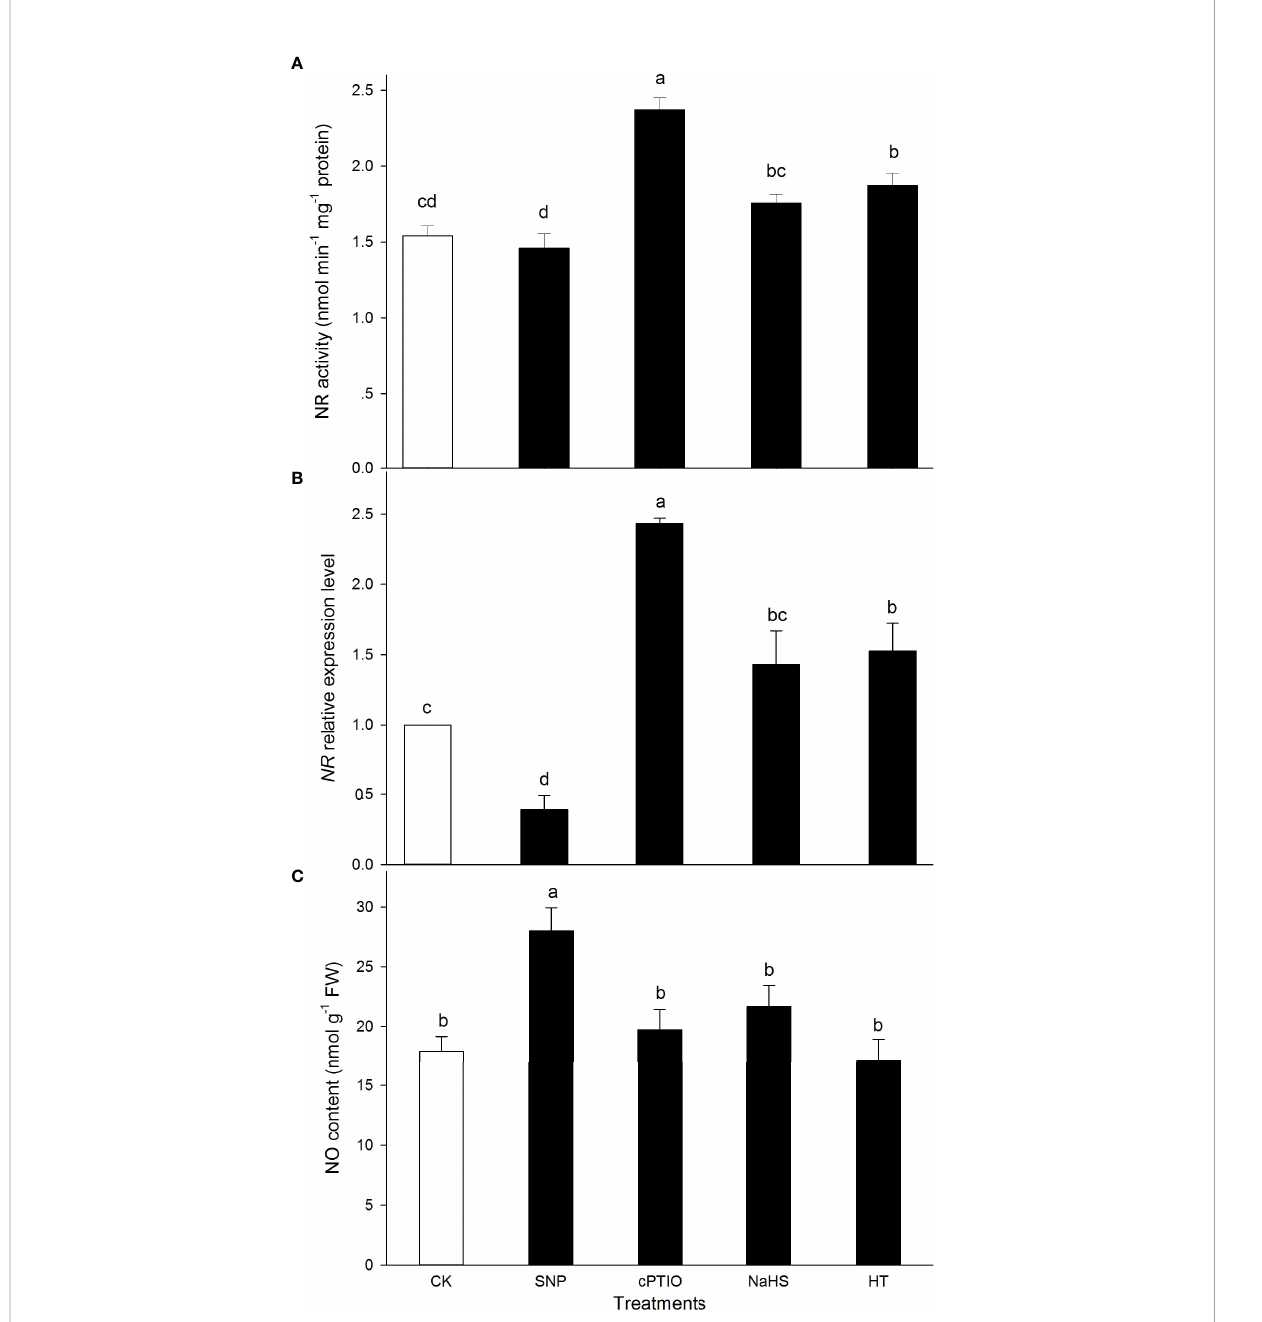
FIGURE 2 Effect of sodium nitroprusside (SNP), 2-(4-carboxyphenyl)-4,4,5,5- tetrameth- ylimidazoline-1-oxyl-3-oxide (cPTIO), sodium hydrosul fi de (NaHS), and hypotaurine (HT) on nitrate reductase (NR) (A) activity, corresponding gene expression (B) , and nitric oxide (NO) content (C) in maize seedlings under non-HS conditions. The data had at least three biological replicates and were tested using Duncan,s multiple-range test at 0.05 signi fi cant level, which denote means ± standard error (SE). The bars with the different letters represent signi fi cant differences, while the same letters represent no signi fi cant